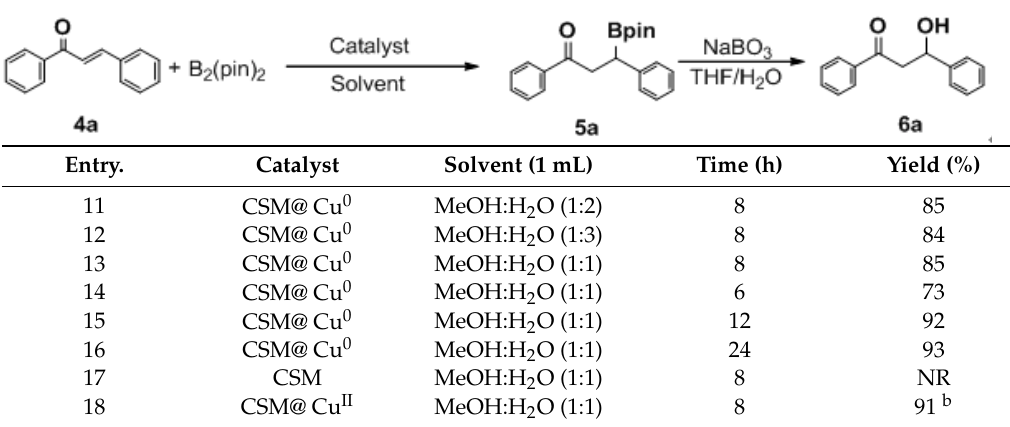
Table 2. Optimization of the Reaction Conditions. Table 2. Cont .